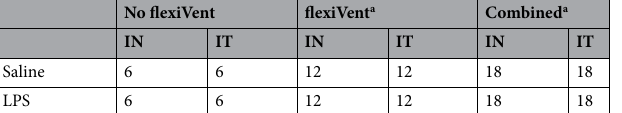
Table 1. Sample size per group. IN intranasal, IT intratracheal, LPS lipopolysaccharides. a The only exception was the contractile assays with excised tracheas, where only half of the mice that underwent measurements with the flexiVent were tested. This reduced the sample size to 6 per group for the mice that underwent measurements with the flexiVent and to 12 per group when the mice tested or not with the flexiVent were